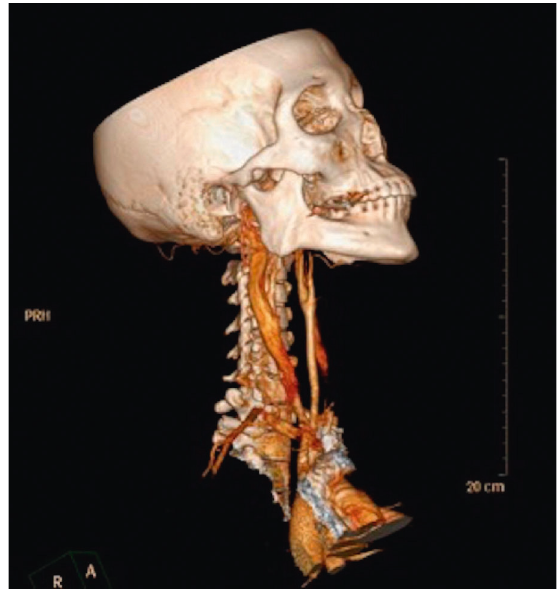
Figure 4: No lesions are evident in large vessels of the